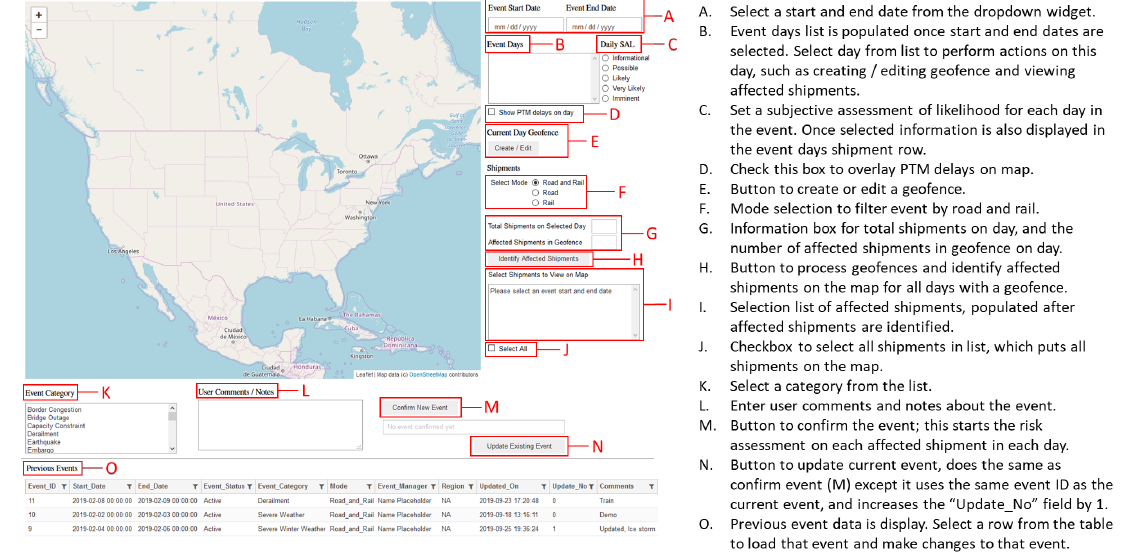
Figure A1. Full graphical user interface (GUI) quick-reference guide.